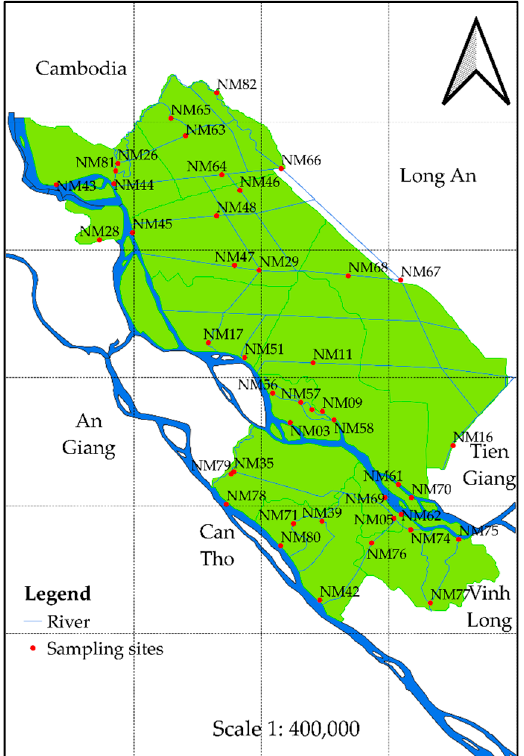
Figure 7. Recommended new sampling sites for water monitoring in Dong Thap province.